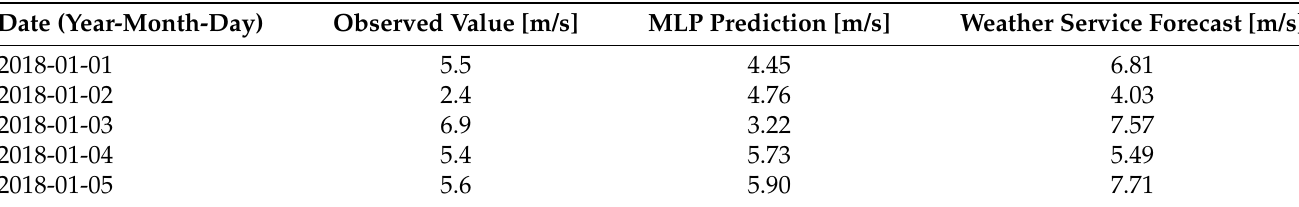
Table A20. Comparison of MLP forecast and weather service for the mean daily wind speed.